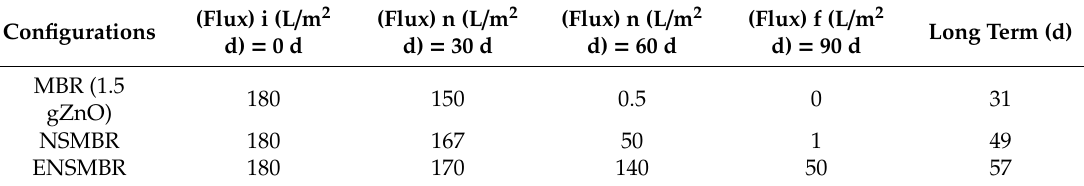
Table 3. Periods of the membrane life span and the deadline for step